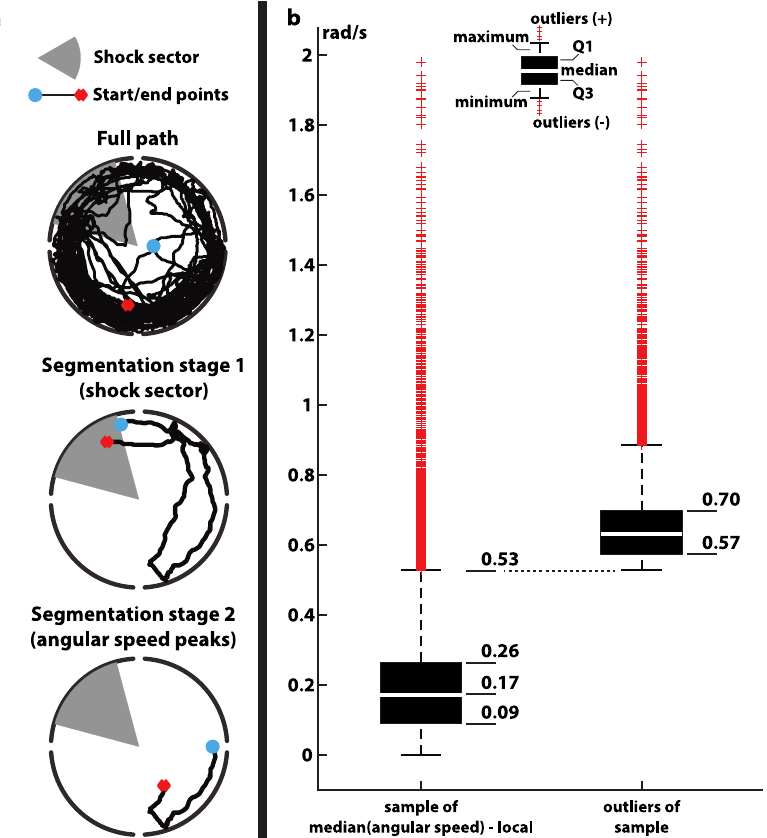
Figure 5. ( a ) Two-step segmentation of the trajectories. In the first step trajectories are split into segments containing only the parts of the paths not falling inside the shock sector. In the second step, sudden changes in the angular speed are taken as the delimiting points of the segments. ( b ) A sample of angular speed changes is taken into consideration and upper outlying values where discarded. These values correspond to sudden changes. Based on this analysis a cut-off value of 0.6 was selected to split the segmented animal paths into subsegments. The cut-off value of 0.5 and 0.55 were also considered for sensitivity